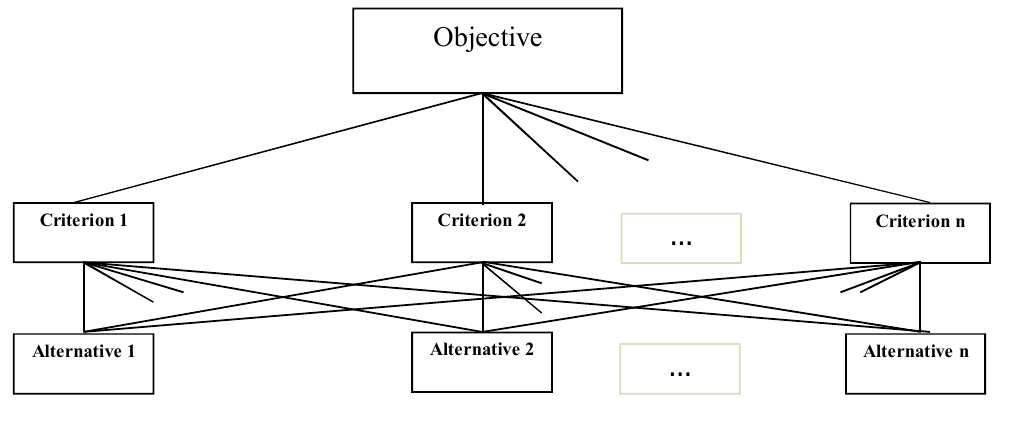
Fig. 1. The structure of